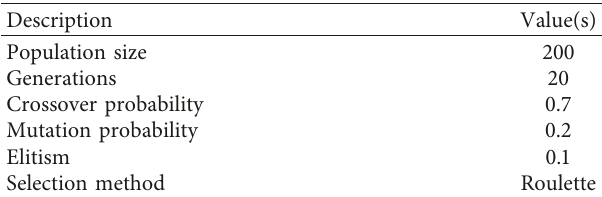
Table 3: GA parameters.